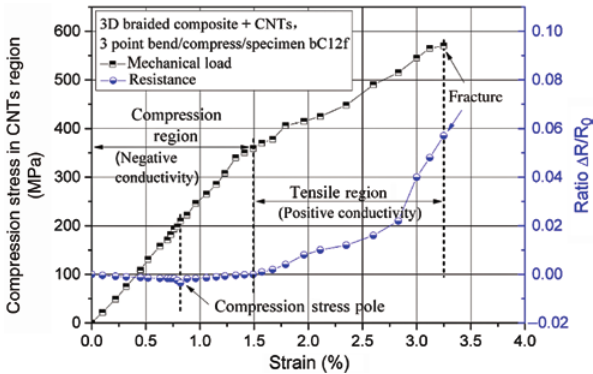
Figure 10: Three-point bending mechanical and electrical resistance results of specimen C in the compressive